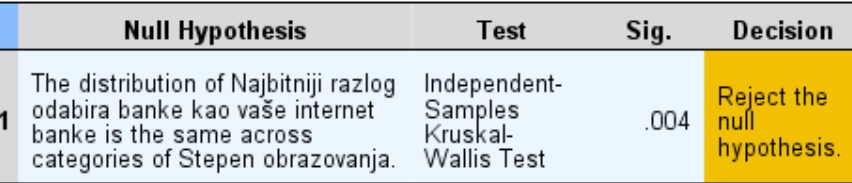
Figure 3. Testing education level groups across reasons of choosing bank using Independent